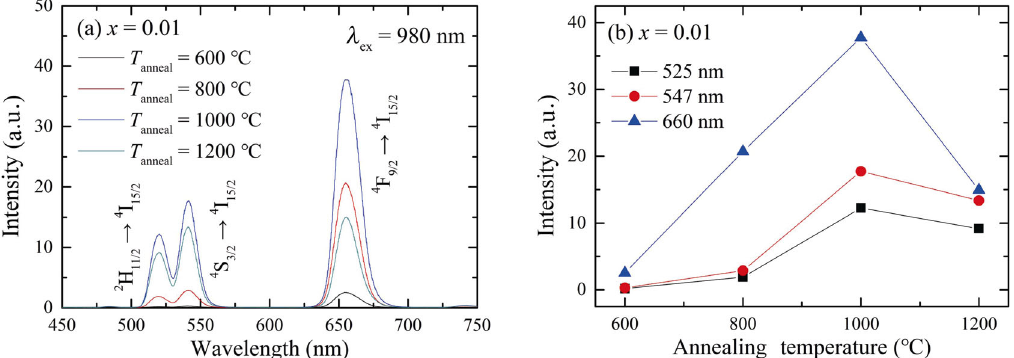
Fig. 7 (a) UC emission spectra of the x = 0.01 NCs annealed at T anneal ( T anneal = 600, 800, 1000, and 1200 ℃ ) under the λ ex = 980 nm photoexcitation. (b) Emission intensities at 525, 547, and 660 nm of x = 0.01 NCs as a function of the annealing temperature ( T anneal